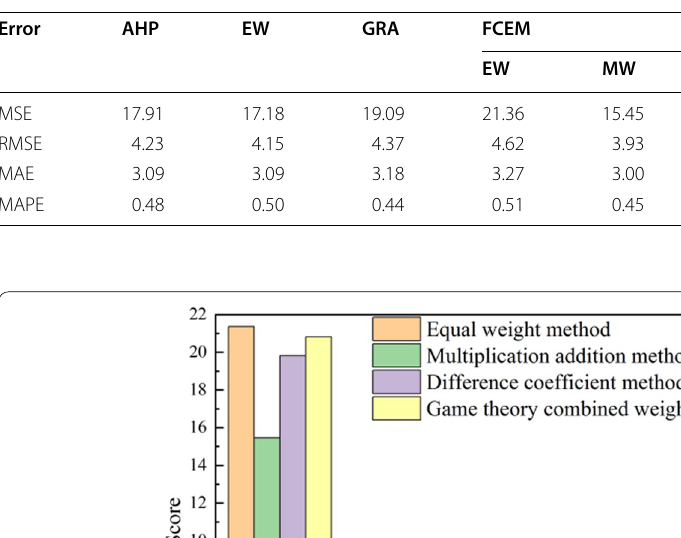
Table 2 Error comparison of each algorithm